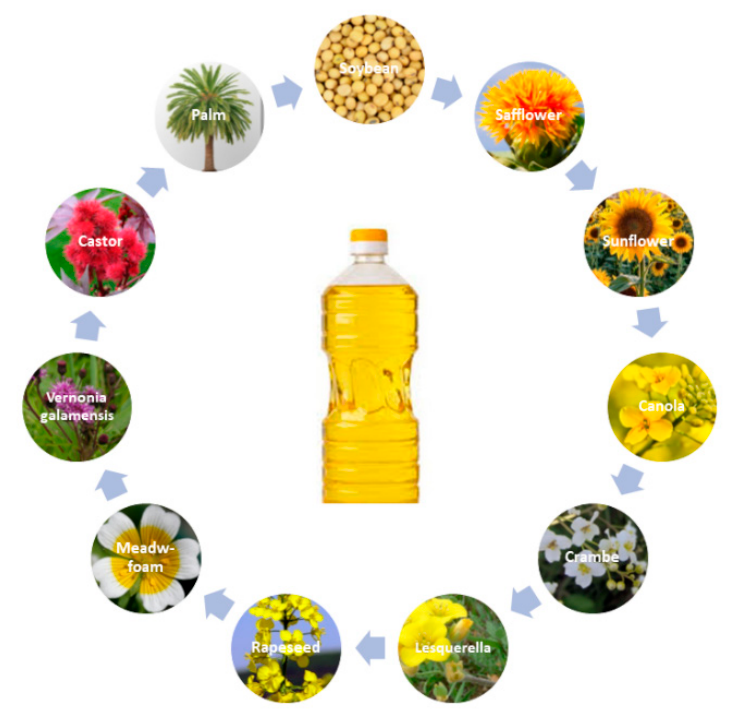
Figure 4. Common botanic oils used in cationic UV curing systems.